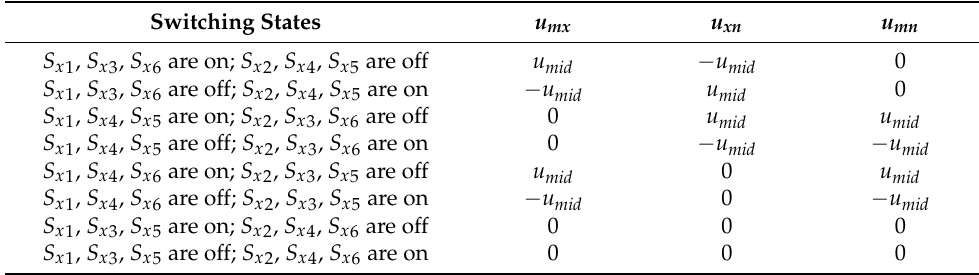
Table 1. Switching states of the middle cell.